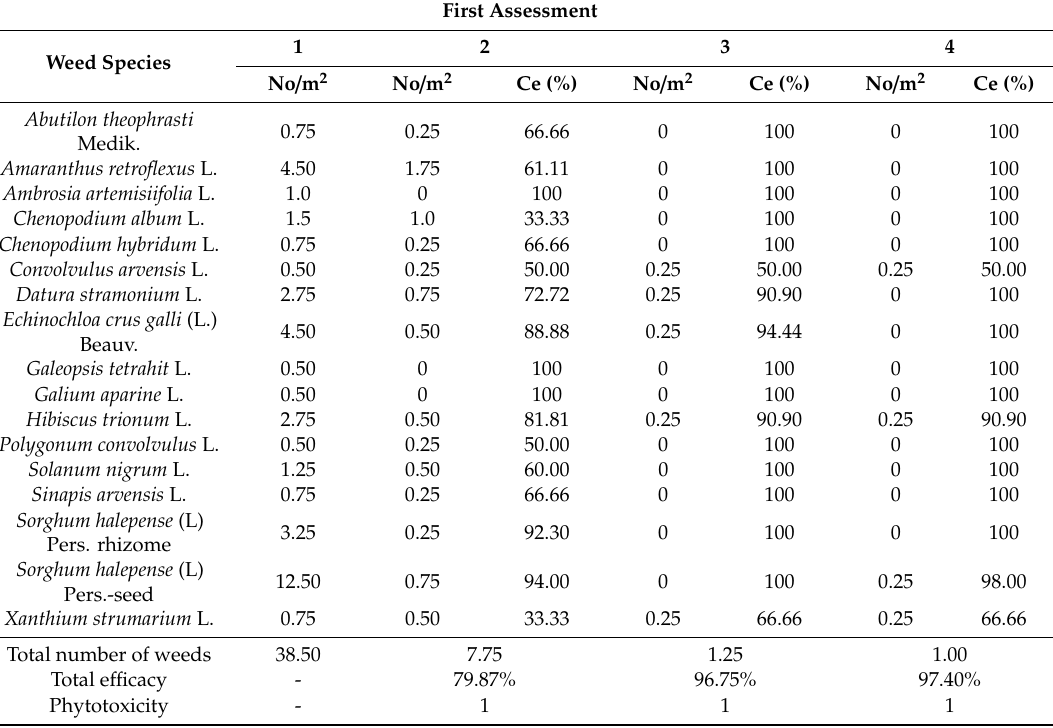
Table 3. E ffi cacy of used herbicides in soybean on the first